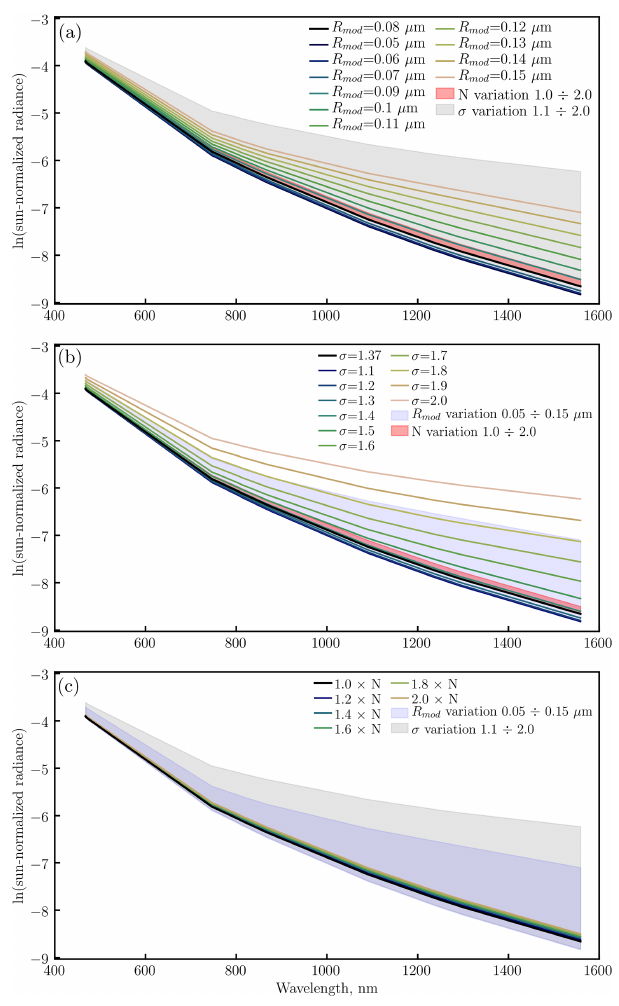
Figure 1. Logarithms of sun-normalized intensities spectra at a tan- gent height of 25km, modelled with different particle size distri- bution parameters. The black line represents the “standard” back- ground conditions.